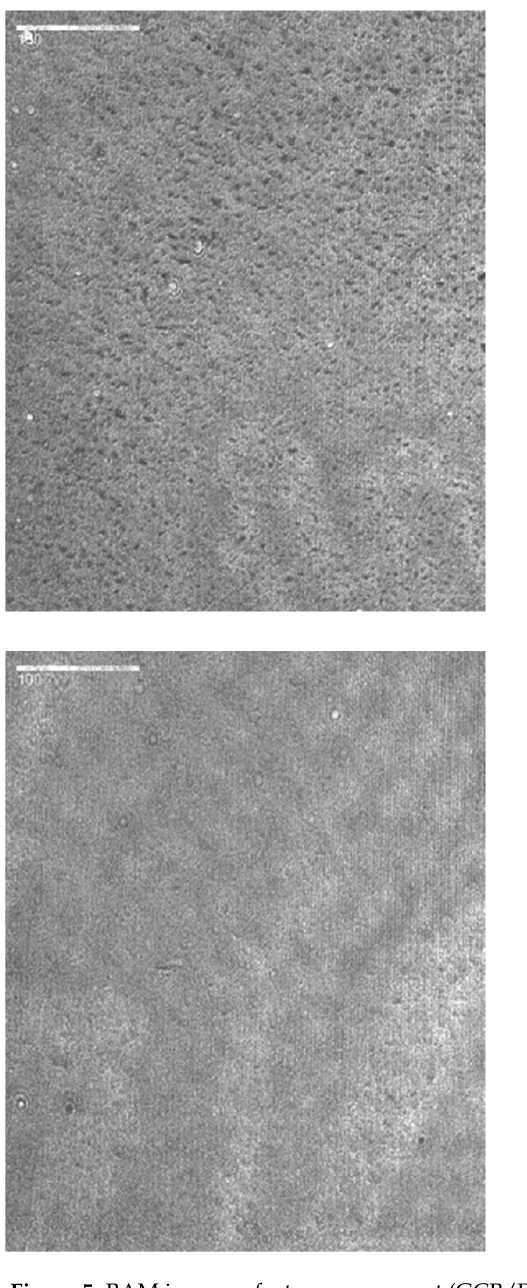
Figure 5. BAM images of a two component (GCB/PA) monolayer on CaCl 2 (aq; 100 mM) at various surface pressures—scale bar represents 100 μm; top left, top right, bottom left, bottom right: 1, 5, 10, 25 mN m −1 .